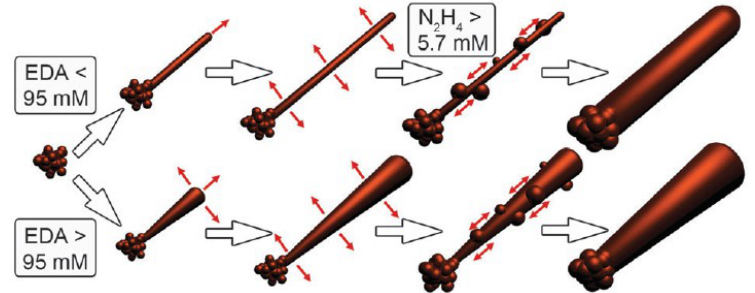
Figure 13. The process of tapering and thickening of Cu NWs in the direction of the red arrows. Reproduced with permission from [44]. Copyright 2014 RSC